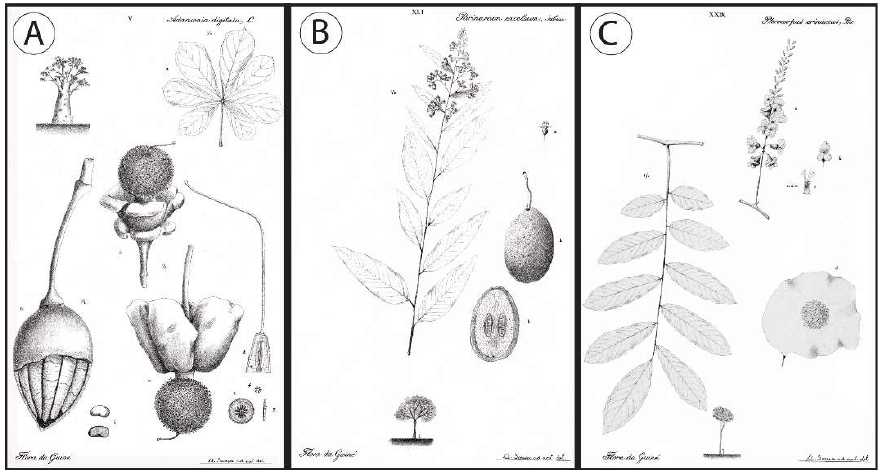
(Figure 3: Adansonia digitata —3A; Parinari excels —3B; Pterocarpus erinaceus —3C). Diversity 2018 , 10 , x